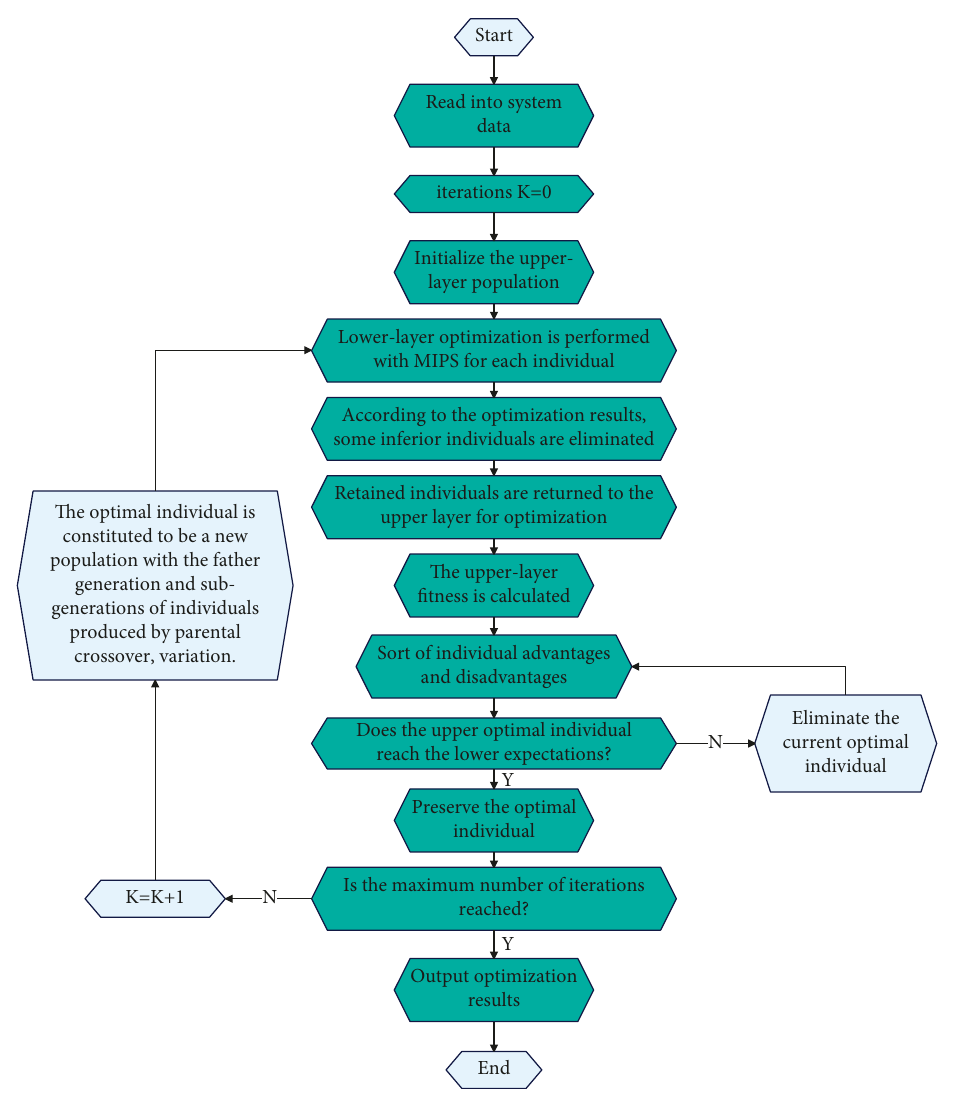
Figure 4: Flowchart of the microgrid bilevel economic dispatch